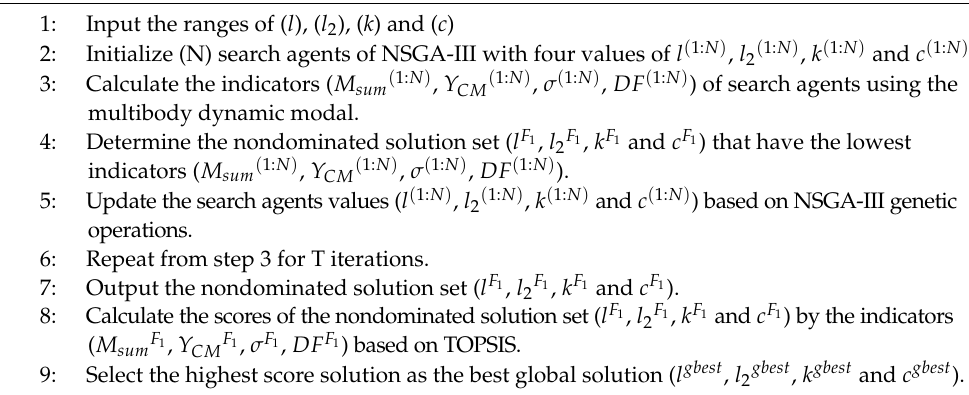
Algorithm 1: Parameters Optimization of the Suspension System Based on NSGA-III and